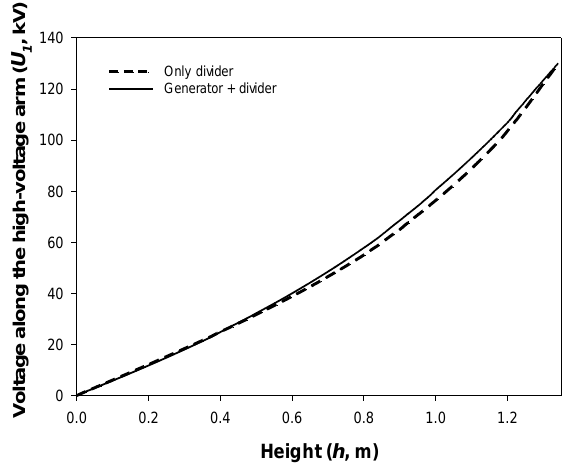
Figure 7. Uneven voltage distribution along the high-voltage arm of the divider considering full assembly (including the AC generator and divider) and only considering the divider.